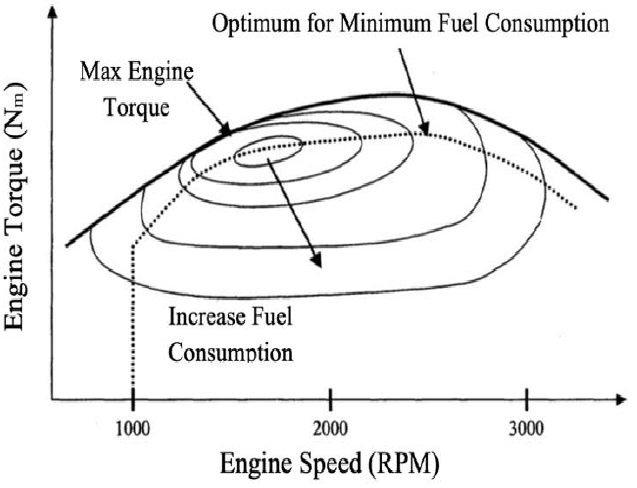
Figure 5. Example of DE characteristics connected with a two-pole generator [34].